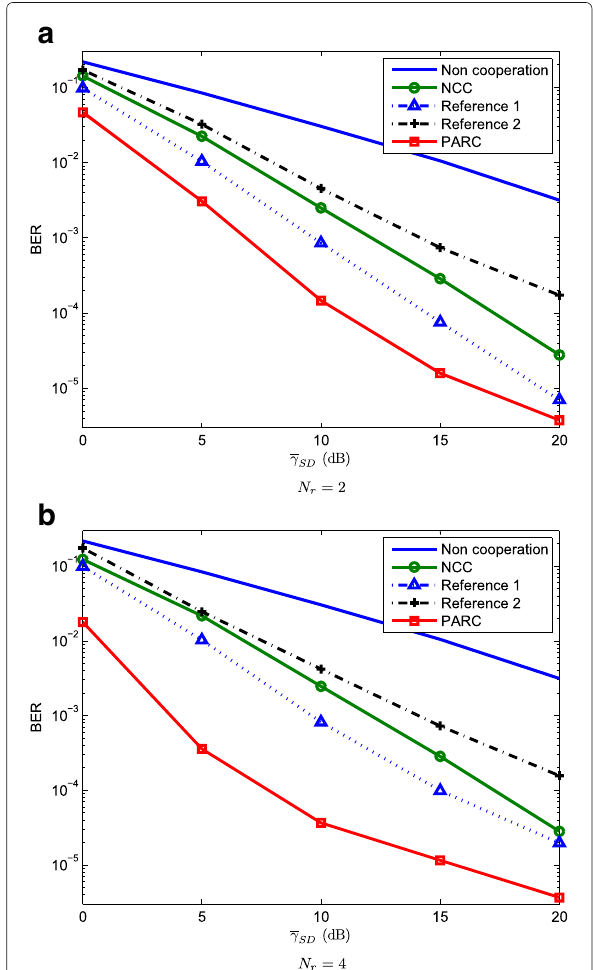
Fig.5 Performance comparisonbetween PARC and NCC when the CC [25 33 37] with the minimum distance f = 12 and the rate 1/3 is